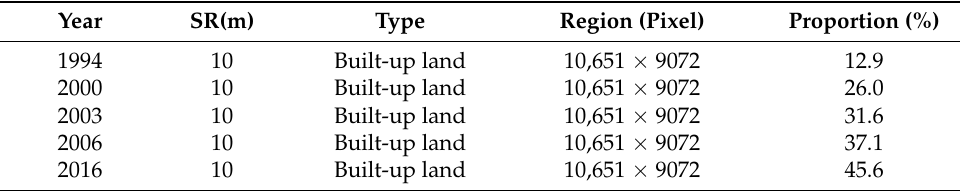
Table 1. Information of raster maps for five